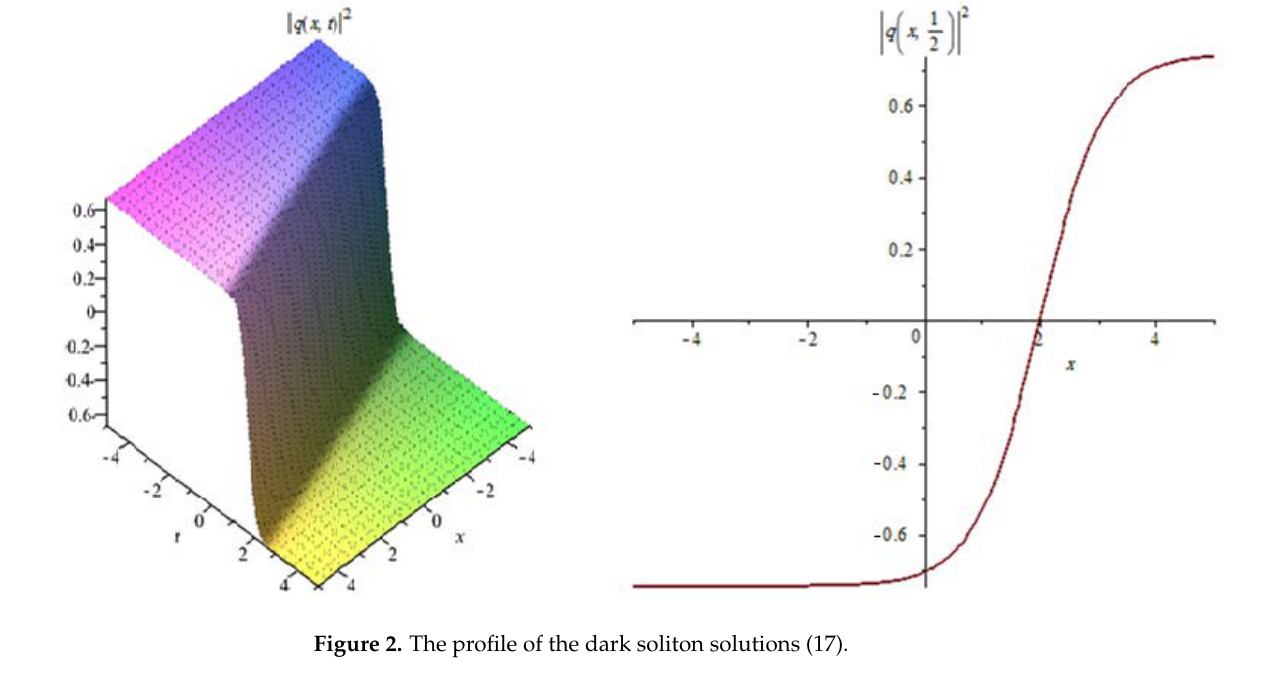
) with ) with ) with 2 2 2